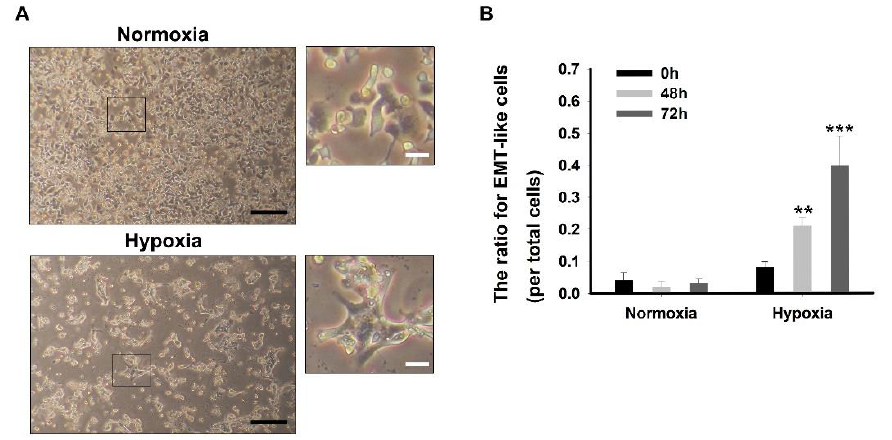
Figure 2. Representative immunofluorescence images for the detection of active mitochondria in pancreatic cancer cells. ( A ) Immunofluorescence staining detection of active mitochondria. Mitochondria tracker (mitotracker) and tetramethylrhodamine (TMRM) fluorogenic dye-stained accumulation with intact membrane potential in pancreatic cancer cells. Each pixel exposure time 0.1 s. Scale bar = 25 μm. ( B ) Quantitative analysis for mean fluorescence intensity of TMRM red fluorescence comparing between normoxia and hypoxia. The results were performed by quintuplicate obtaining repetitive results. A total of five cells with relatively high fluorescence intensity on one slide of each group was considered as a single analysis. ** P < 0.001 vs. normoxia. Results are mean ± SD.